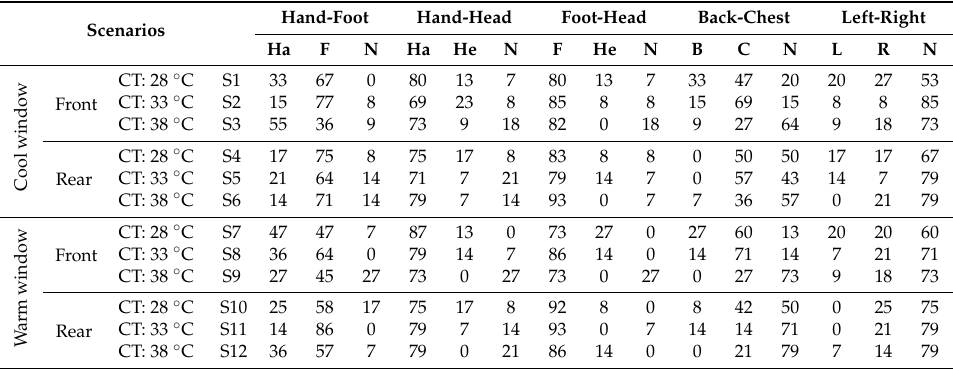
Table 6. Asymmetric test: percentage (%) of participants voted perceived cooler body-part compared to its pair in the questionnaire. CT, Front, Rear stand for the ceiling temperature, Front position (1 m to the artificial window) and Rear position (3 m to the artificial window). Ha: Hand, F: Foot, N: No difference, He: Head, B: Back, C: Chest, L: Left and R: